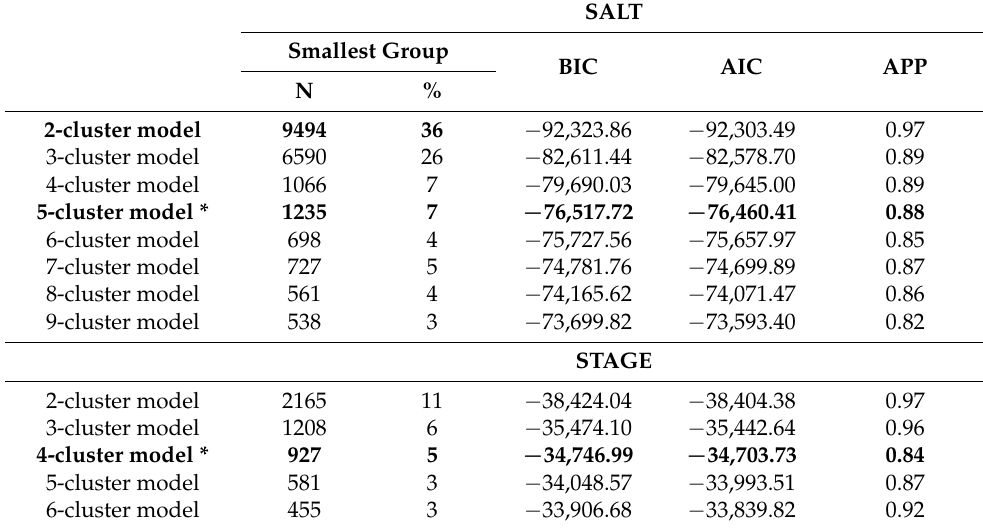
Table 2. Goodness-of-fit statistics of the group-based trajectory analysis models.